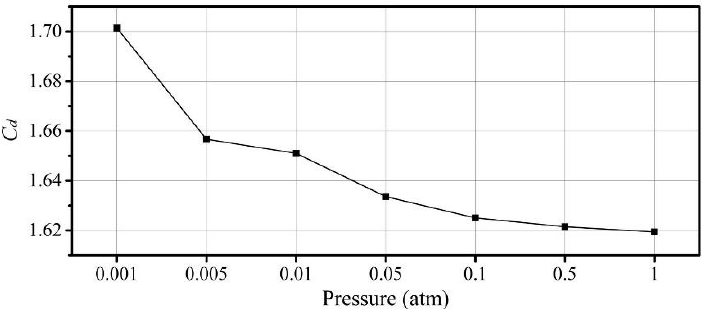
Figure 15. Relationship between the drag coefficient and ambient pressure in the tube at 400 m/s.